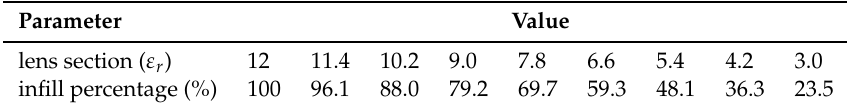
Table 1. Relative permittivity values and corresponding infill percentage of each section of the transformed lens, using one filament of ε r = 12.